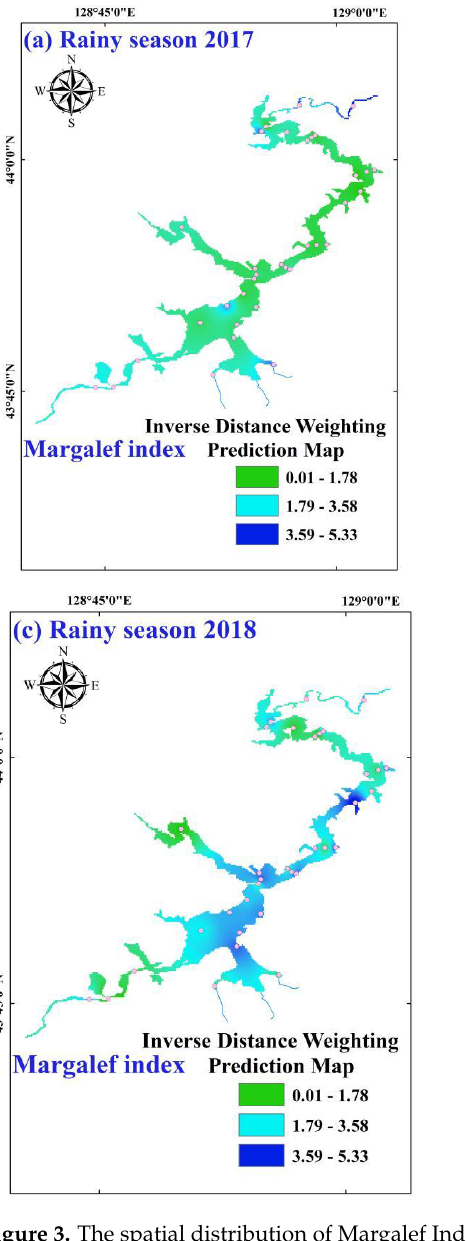
Figure 3. The spatial distribution of Margalef Index in study period. ( a ) Rainy season (August 2017); ( b ) dry season (October 2017); ( c ) rainy season (August 2018); ( d ) dry season (October 2018). The interpolation map was constructed by ArcGIS software using the Inverse Distance Weighting method.